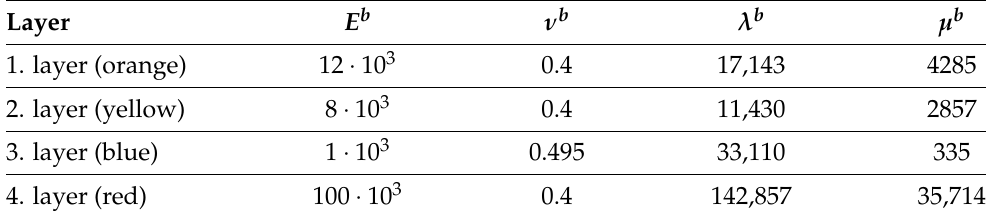
Figure 4. Nonhomogeneous model of VFs formed by four layers with triangulation. Modeled layers: 1. muscle, 2. ligament, 3. superficial lamina propria and 4. epithelium. Table 4. Prescribed material constants for the VFs model: Young modulus, Poisson ratio and Lamé parameters for different layers, ordered from the lower layer to the upper layer. See Figure 4 for the visualization of the corresponding